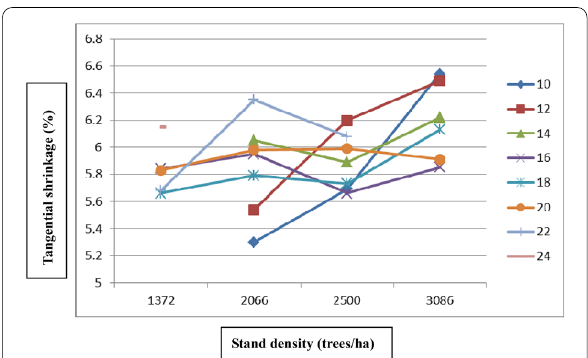
Fig. 4 Tangential shrinkage in relation to stand density and DBH class